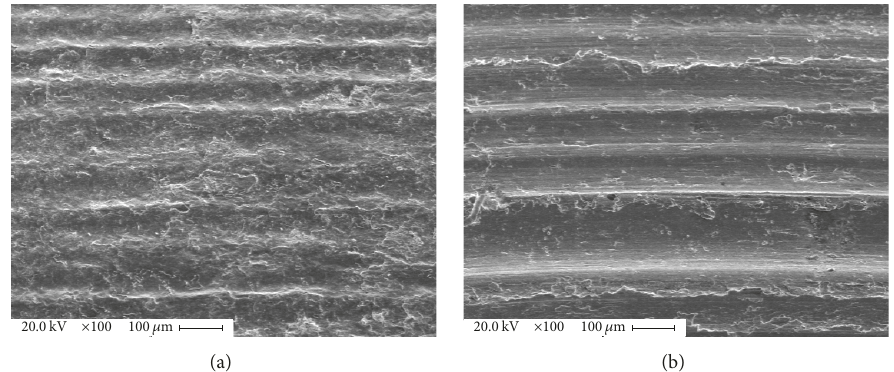
Figure 4: Wear scars of (a) 20CrMnTi pins against chroming T10 disc and (b) 20CrMnTi pins against nonchroming T10 disc after dry